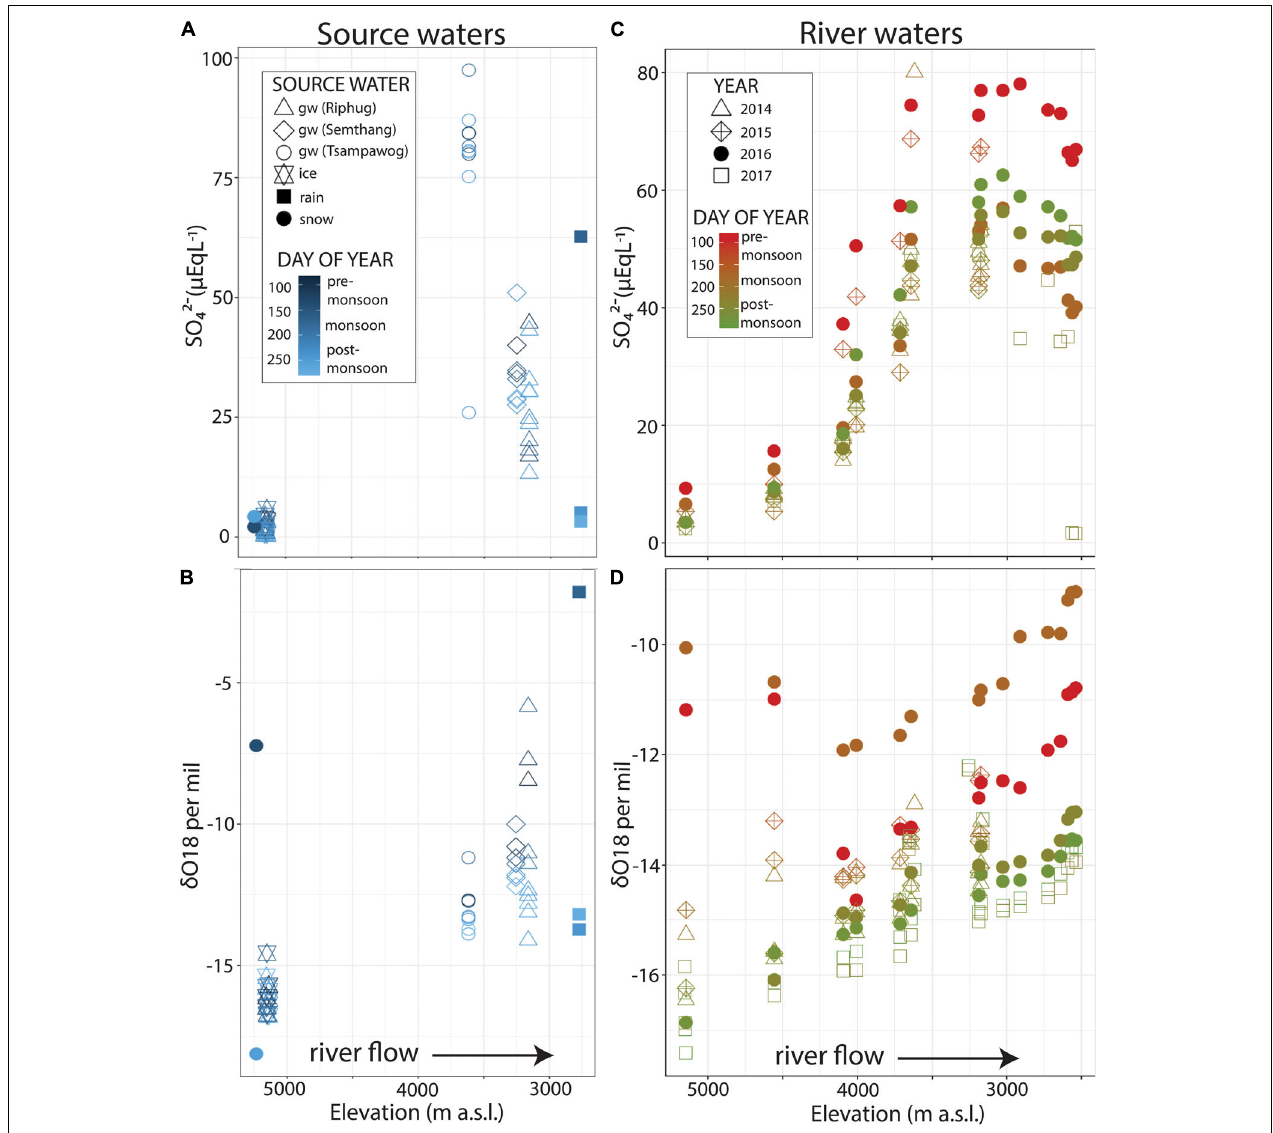
FIGURE 7 | Elevation gradients of source waters (A,B) and river waters (C,D) for SO 42 - (A,C) and δ 18 O (B,D) indicating the evolution of river water as it moves downstream (x-axis decreases in elevation from left to right). Color gradient demonstrates seasonal